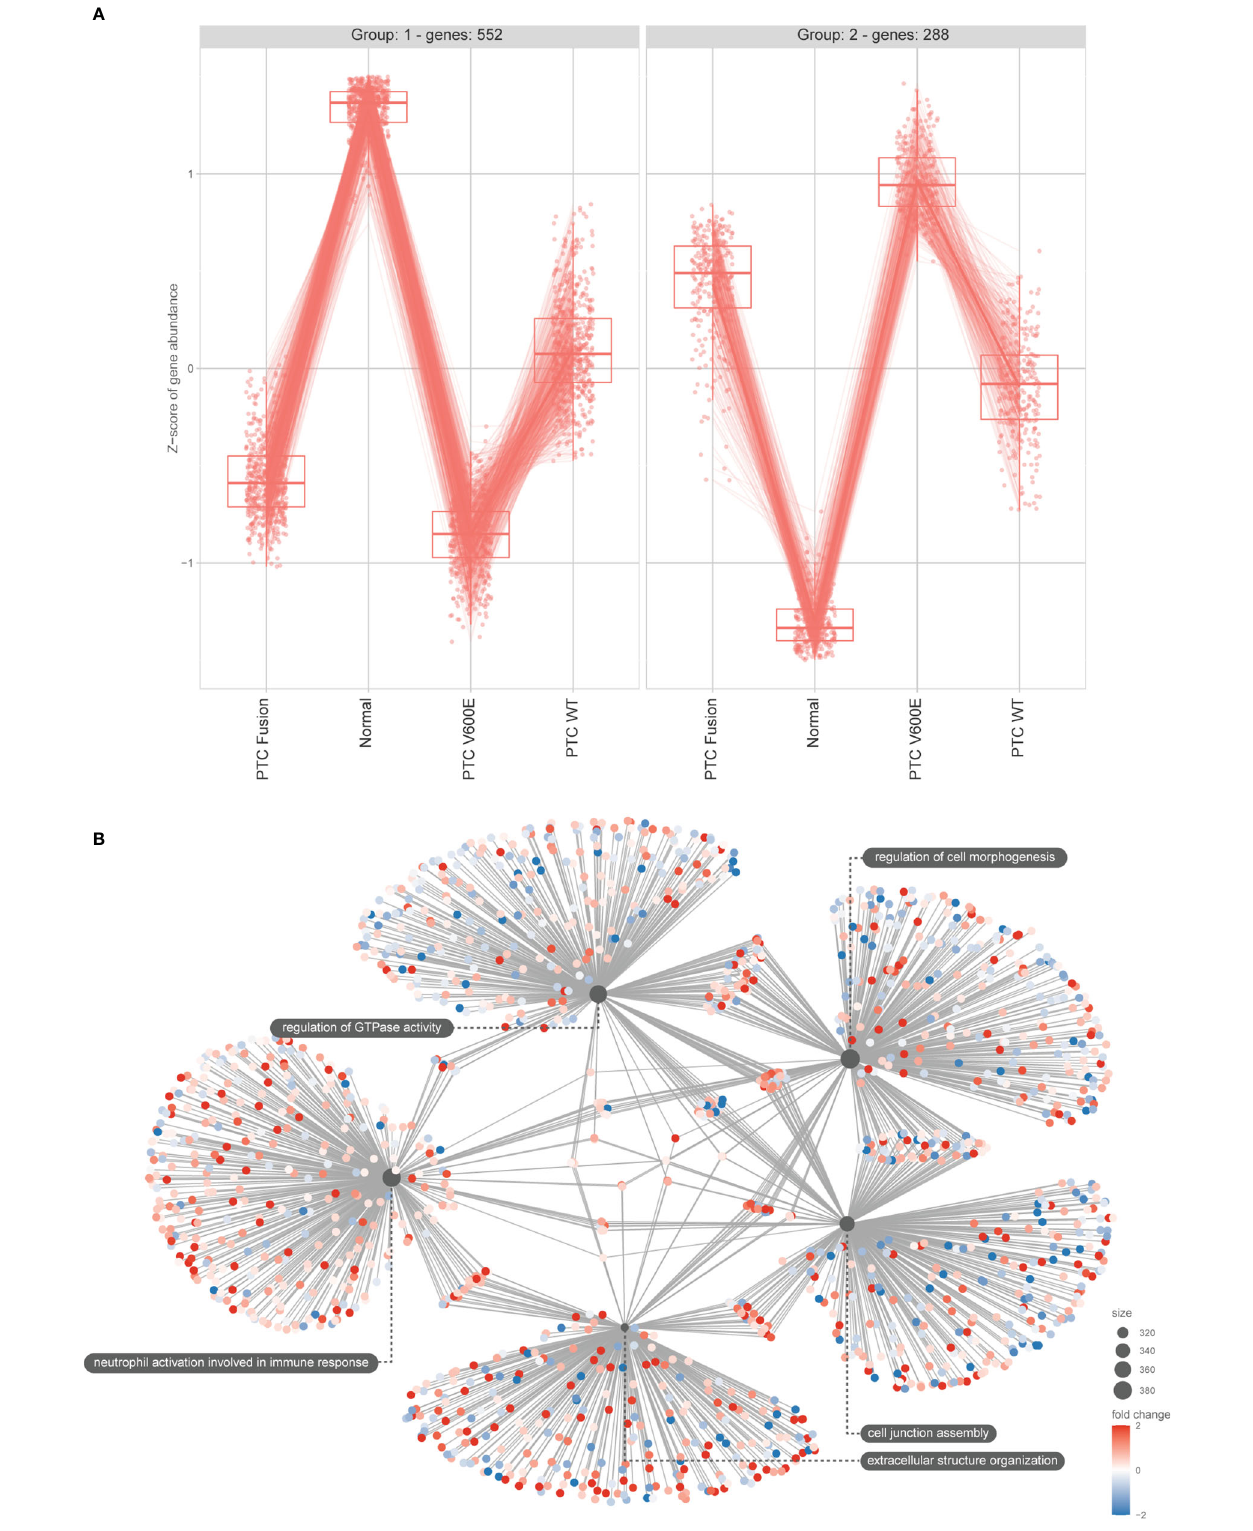
FIGURE 3 DEGs main clusters reinforce the BRAF V600E signature on PTC samples and functional enrichment reveals top modulated processes. (A) The plot shows the result of the clustering of the top 1000 DEGs obtained using LRT for the mRNA seq dataset. Min genes = 100. (B) Category netplot shows the correlation between the genes associated with the top fi ve most enriched GO terms and the fold changes of the signi fi cant genes associated with these terms